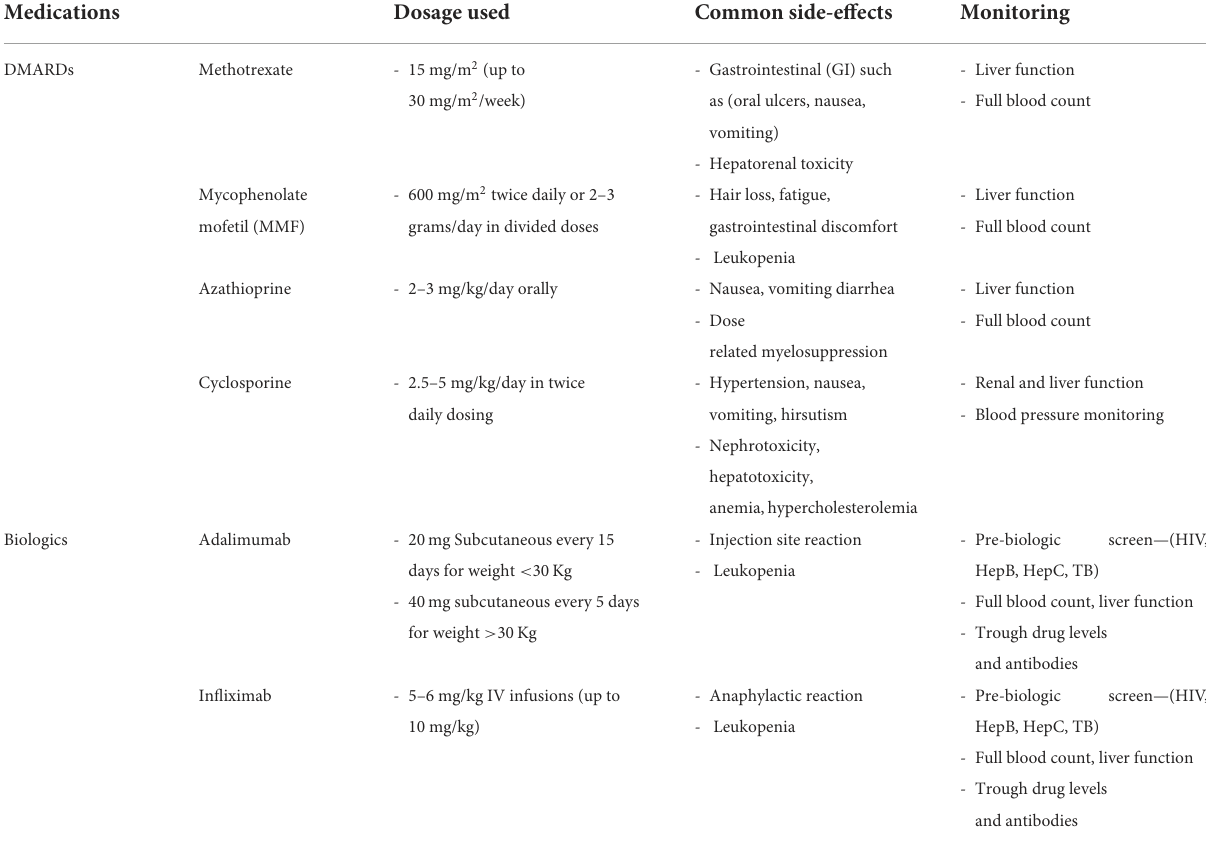
TABLE 4 Medications and